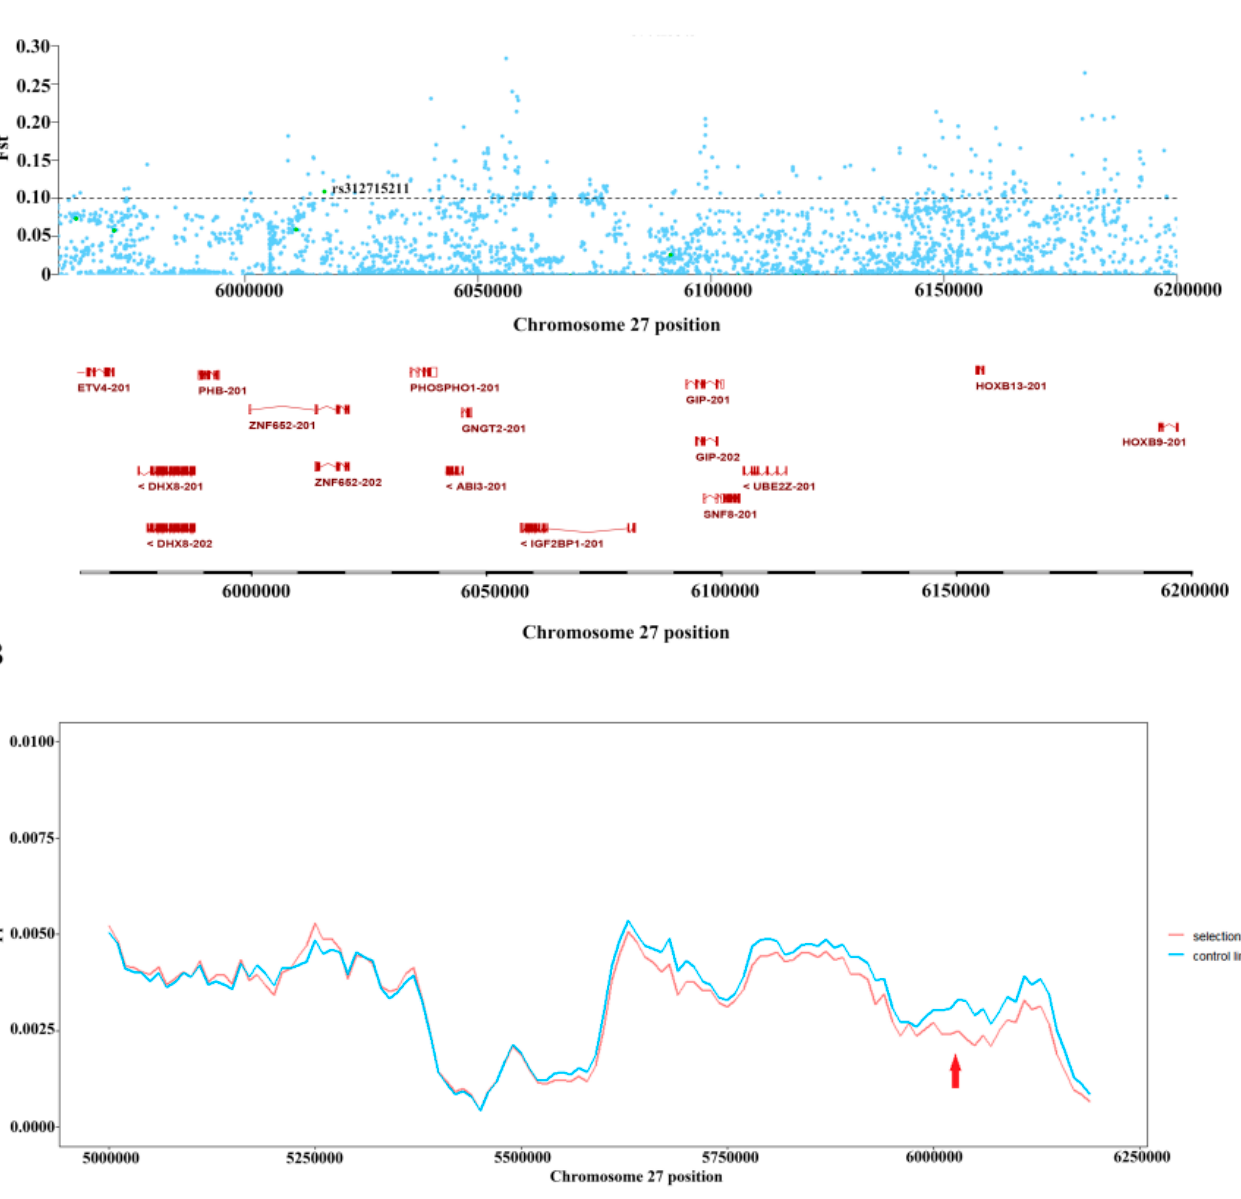
Figure 4. Locations of the candidate regions F ST and π . ( A ) Localized genome − wide association study (GWAS) and F ST . Green represents significant SNPs located by GWAS (Chr27: 5,963,734–6,119,680). Only rs312715211 reached the F ST threshold line. ( B ) Single nucleotide polymorphisms ( π -values) in significant regions. Table 3. Candidate SNP and